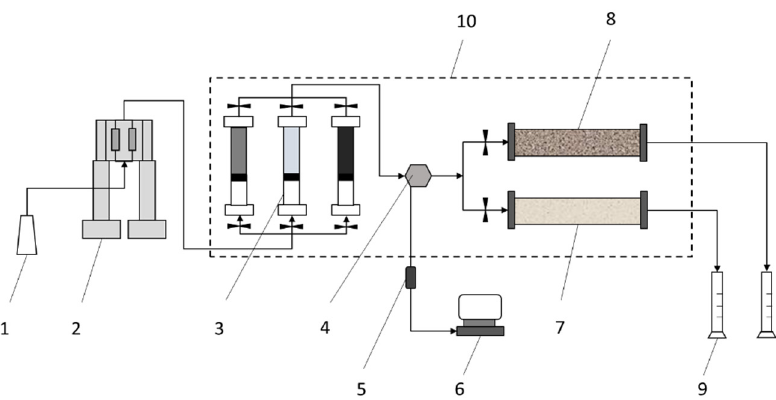
Figure 1. Schematic of the sand pack model displacement apparatus. 1, distilled water; 2, ISCO pump; 3, intermediate container; 4, six-way valve; 5, pressure sensor; 6, pressure acquisition system; 7, low-permeability sand pack model; 8, high-permeability sand pack model; 9, measuring cylinder; 10, temperature control box.